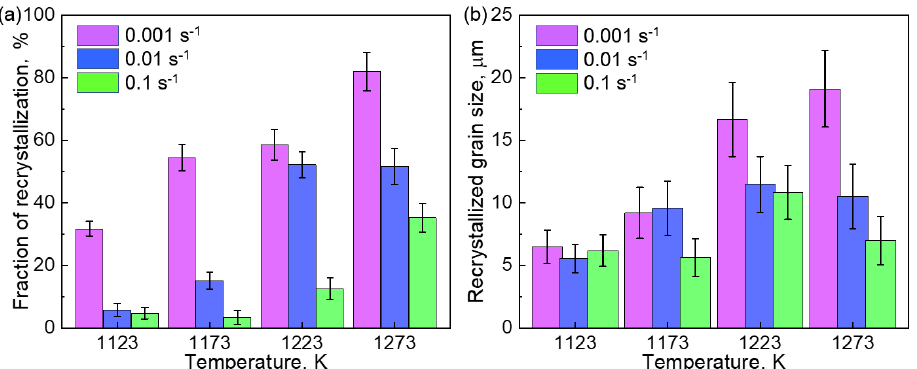
Figure 9. The volume fraction ( a ) and average diameter ( b ) of the DRXed grains in the hot-compressed Co 35 Cr 25 Mn 15 Ni 15 Fe 10 TRIP-HEA. The compression temperatures were 1123, 1173, 1223, and 1273 K, and the strain rates were 0.001, 0.01, and 0.1 s −1 .